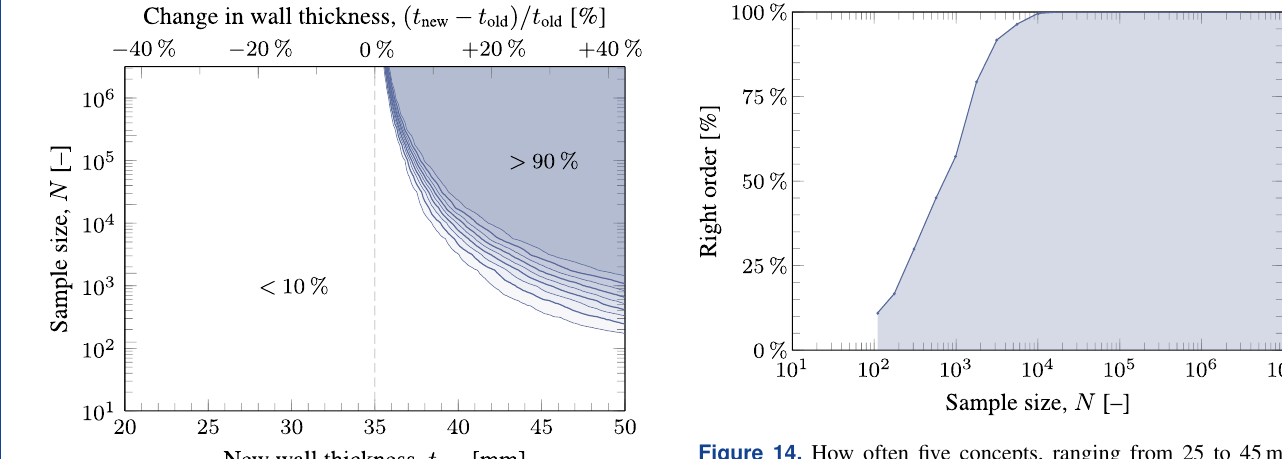
Figure 14. How often five concepts, ranging from 25 to 45mm wall thickness, are ranked in the right order from lowest stress to highest using a fitting-before-aggregation approach with a Gumbel fitted above a